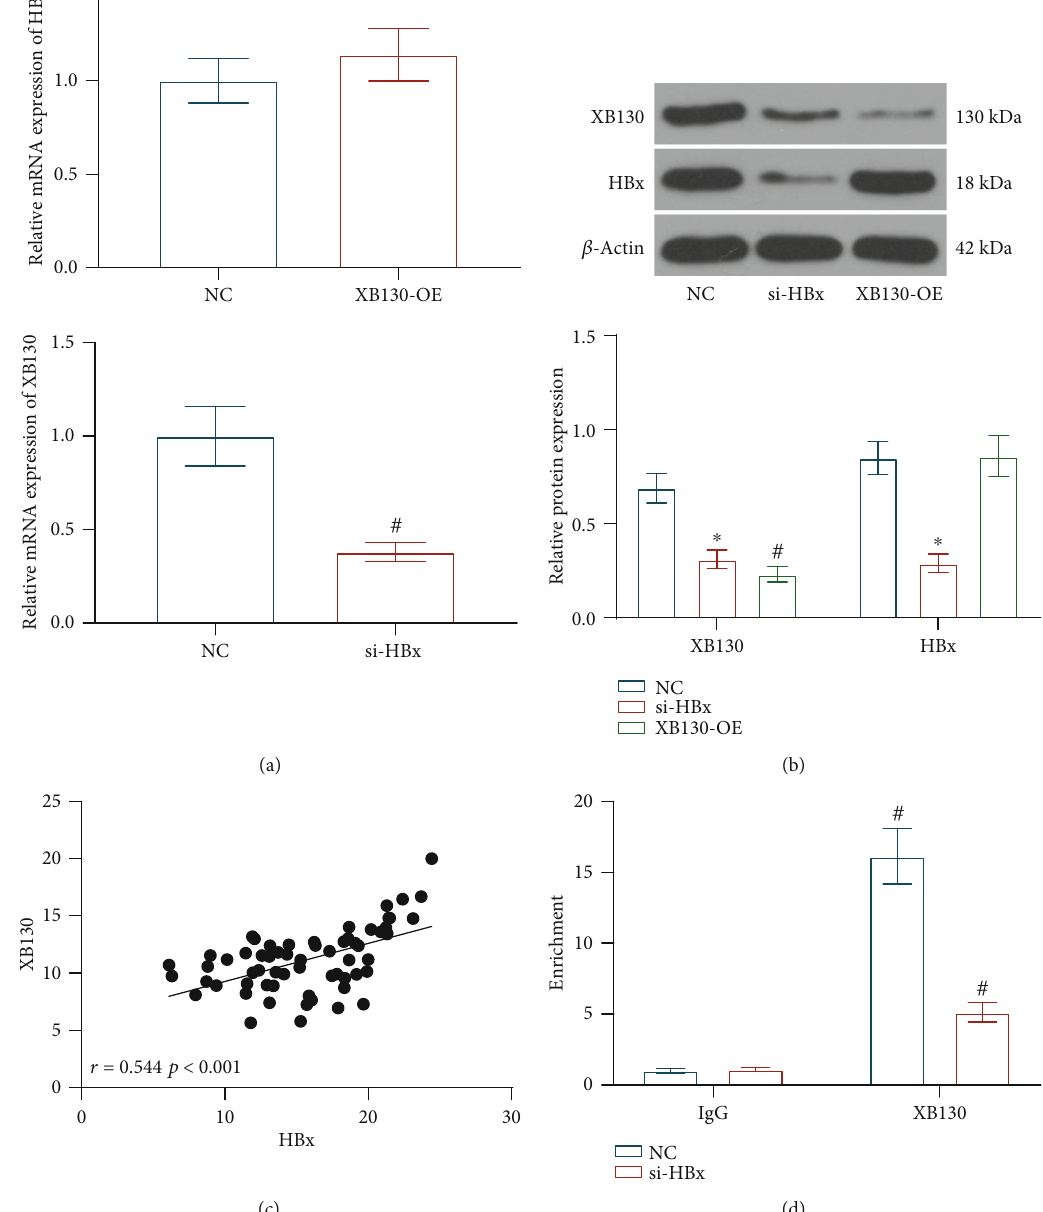
Figure 3: Binding relation of HBx with XB130 in HepG2 cells. (a, b) mRNA and protein expression of HBx and XB130 in HepG2 cells with high expression of XB130 and low expression of HBx determined by RT-qPCR and Western blot analysis. (c) Correlation of XB130 with HBx in liver cancer tissues. (d) Binding relation between HBx and XB130 analyzed by RIP. ∗ # p < 0 : 05